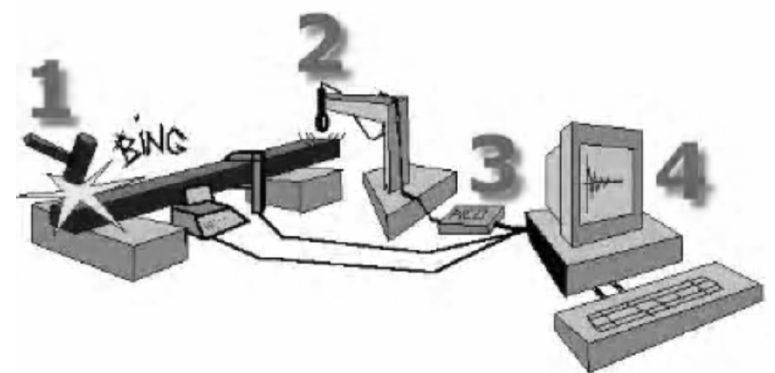
Fig. 2. Schematic view of the most common setup for free vibration on a free-free bar test